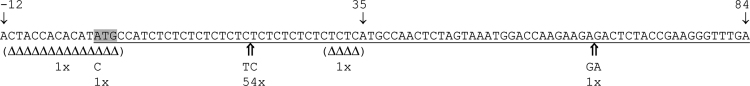
Mutational spectrum of 58 revertants of the fbp1MS2 allele. Numbering above the sequence is in relation to the translation start (start codon is shaded), deleted stretches are indicated by (Δ), a gain of one TC repeat in the engineered TC microsatellite and one GA repeat in an innate GA repeat is indicated by an arrow (⇑). The reversion window, where potential reversions have to be located is underlined.